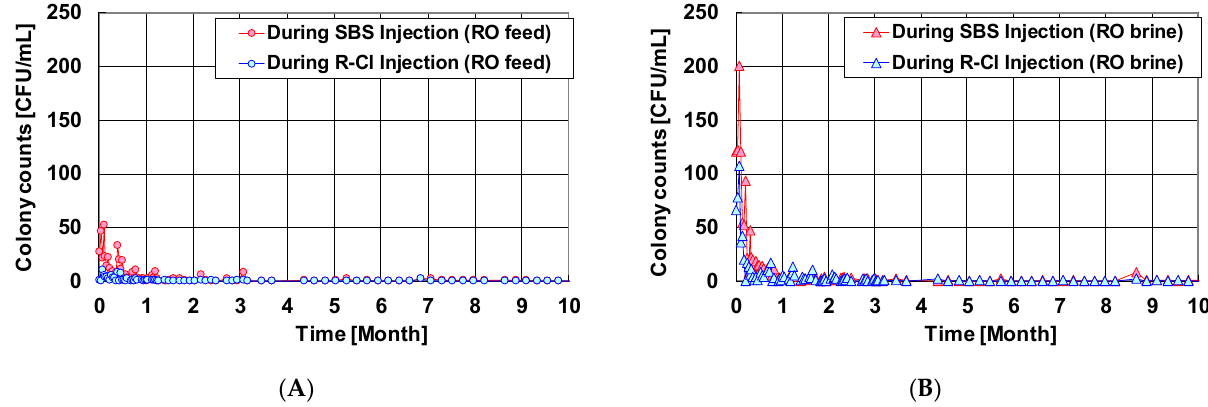
Figure 12. Colony counts results of ( A ) feed seawater and ( B ) RO brine during ICI. The target residual chlorine concentration was 0.1 to 0.2 mg/L with the frequency of chlorine injection at 3 times per 24 h where each time was 1 h. Data from [89,90].